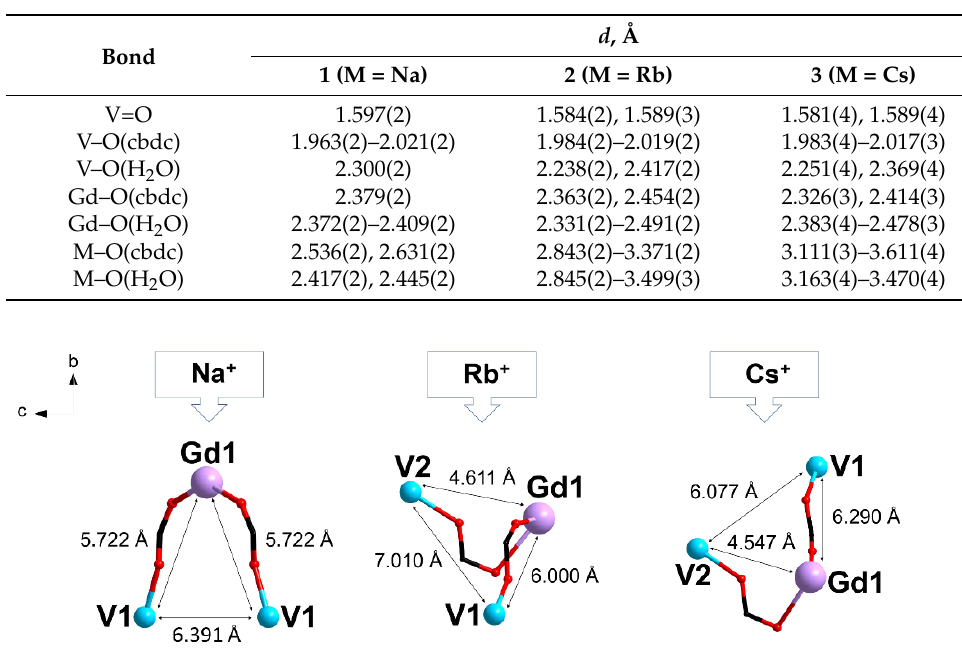
Figure 6. Octanuclear structure of 3 : two {GdV 2 } – units linked by two Cs + cations (H atoms and cyclic fragments of the carboxylate ligands are not shown). [Symmetry code: (a) 2 − x, 2 − y, 1 − z]. Table 1. Selected bond lengths d in complexes 1 – 3 .